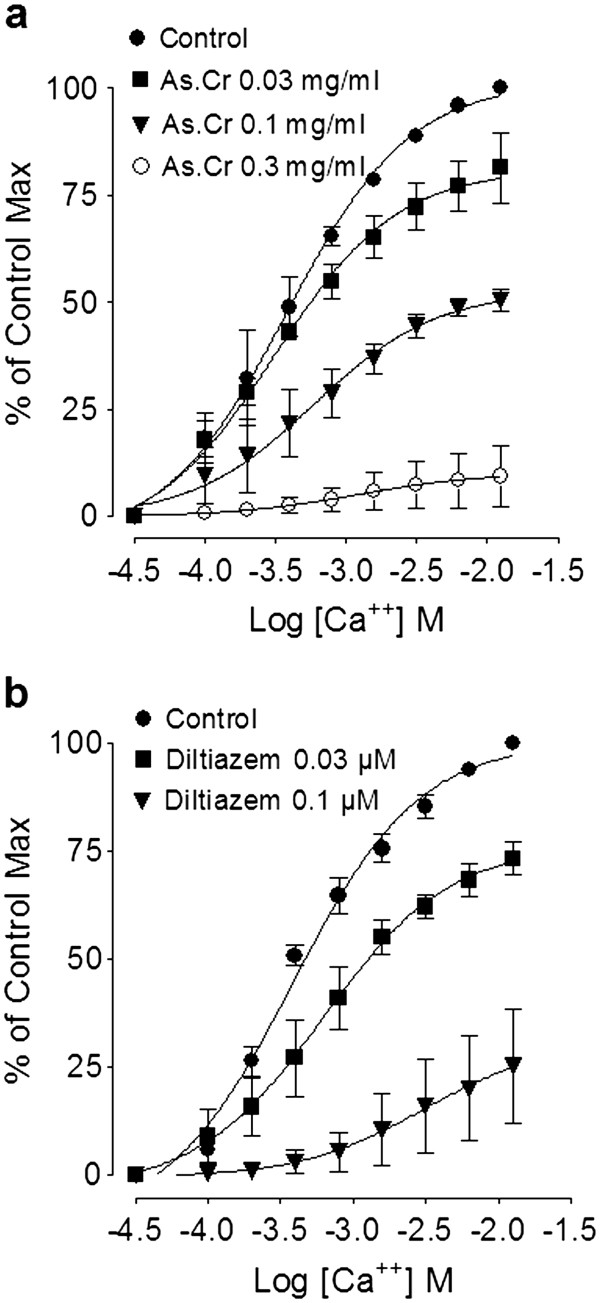
Concentration-response curves of Ca++in the absence andpresence of (a) thecrude extract ofA. spinosus(As.Cr) and (b) diltiazemin isolated rabbit jejunum. Values are expressed as mean ± S.E.M., n = 4.